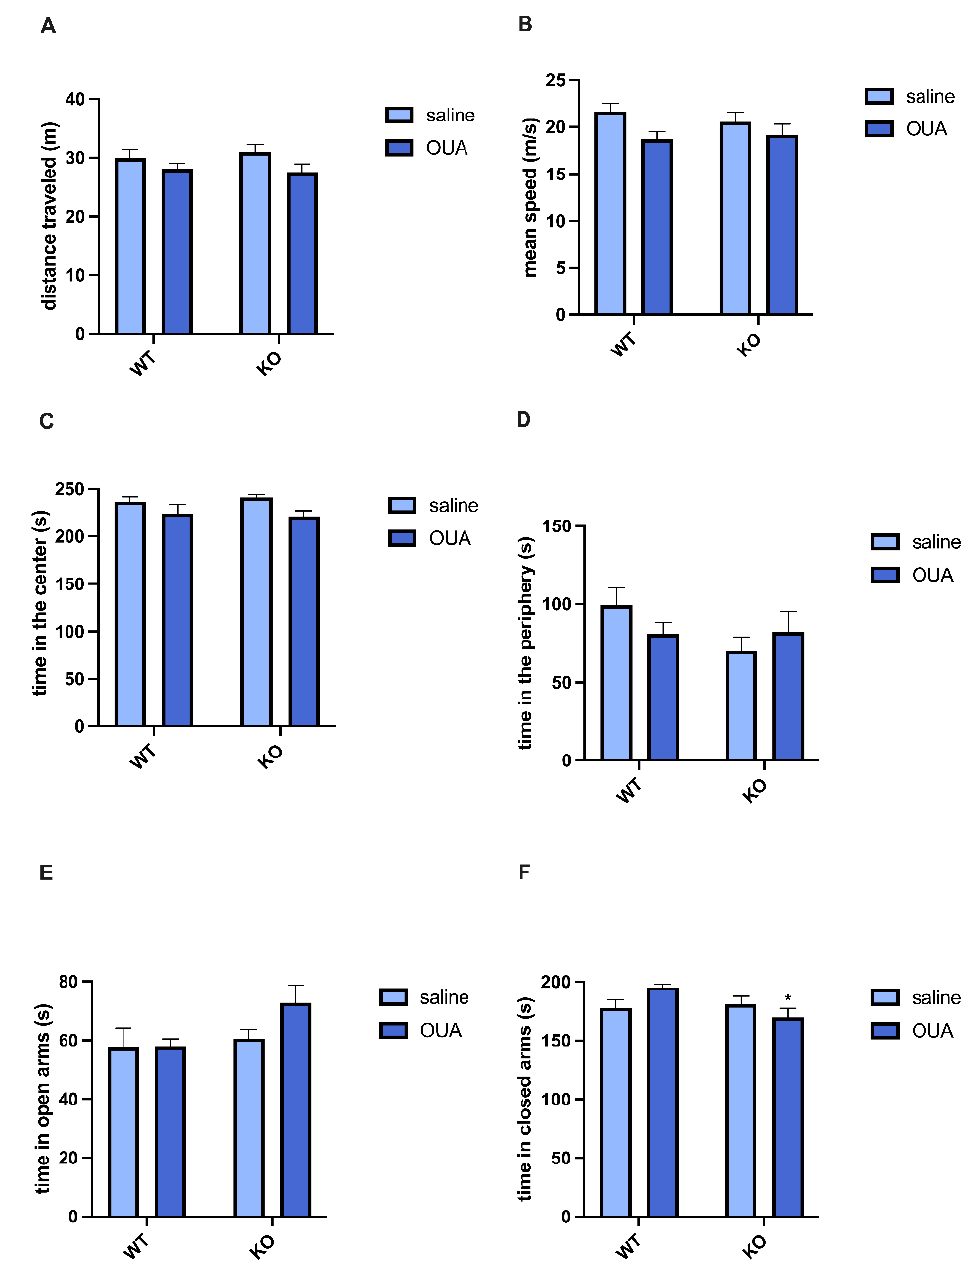
Figure 5. Ouabain causes changes in behavior even after 24 h (open field) and 48 h (plus-maze) after ouabain injection. ( A ) corresponds to the distance traveled, and there is a decrease in this parameter for the ouabain factor [F (1, 49) = 4175]. ( B ) represents the mean speed which is also decreased for the ouabain factor [F (1, 46) = 4967]. ( C ) corresponds to the time in the center that has a decrease for the ouabain factor [F (1, 48) = 5638]. ( D ) represents the time in the periphery that does not have any changes between the groups. ( E ) corresponds to the time in the open arms in the elevated plus-maze test, and no changes between the groups were found. ( F ) corresponds to the time in closed arms in the elevated plus-maze test, and ouabain decreases the time in closed arms in TNFR1 KO mice compared to WT treated with ouabain, * OUA WT (* p < 0.05). Results are expressed in seconds (mean ± SEM) for open field test ( n = 10, N = 3) and for plus-maze ( n = 9, N = 3). Only mean speed is expressed in meters per second (mean ± SEM). The samples were analyzed by two-way ANOVA followed by Tukey’s